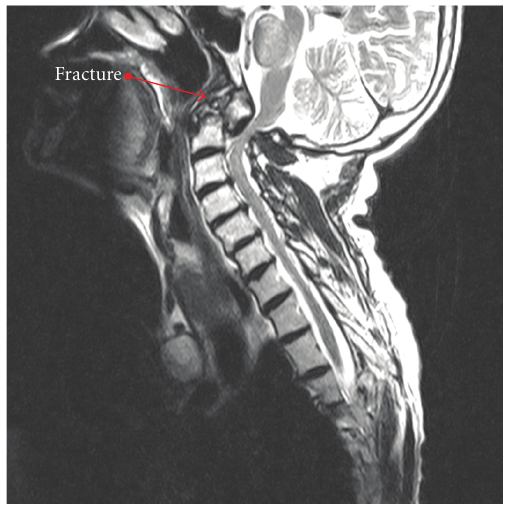
Figure 1: It shows a contrasted MRI with cervical spine fracture.